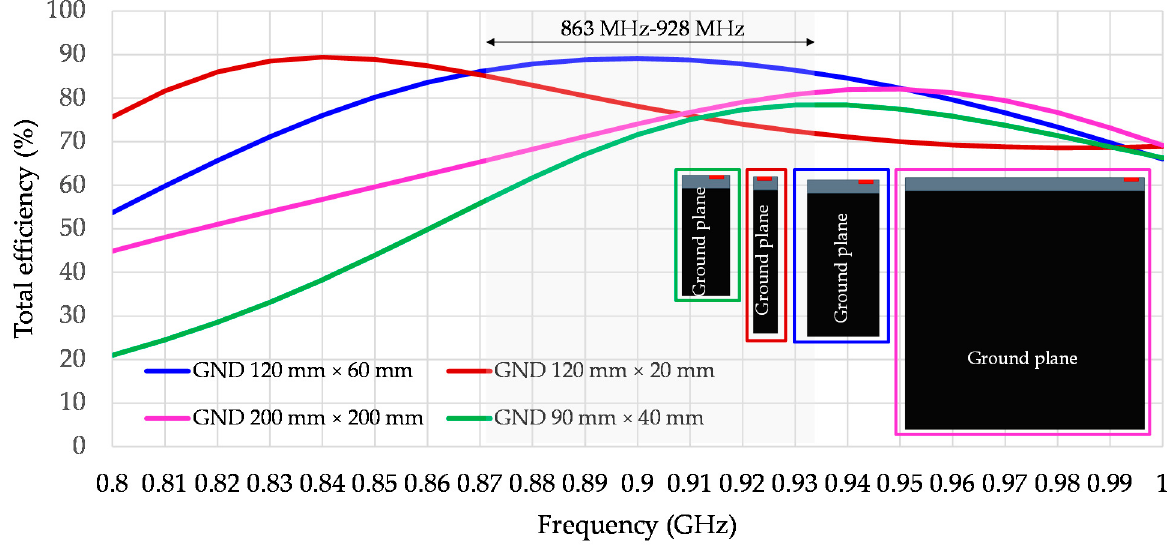
Figure 11. Simulated total efficiency for different cases embedding a 12 mm × 3 mm × 2.4 mm antenna booster with the same matching network as Figure 2.